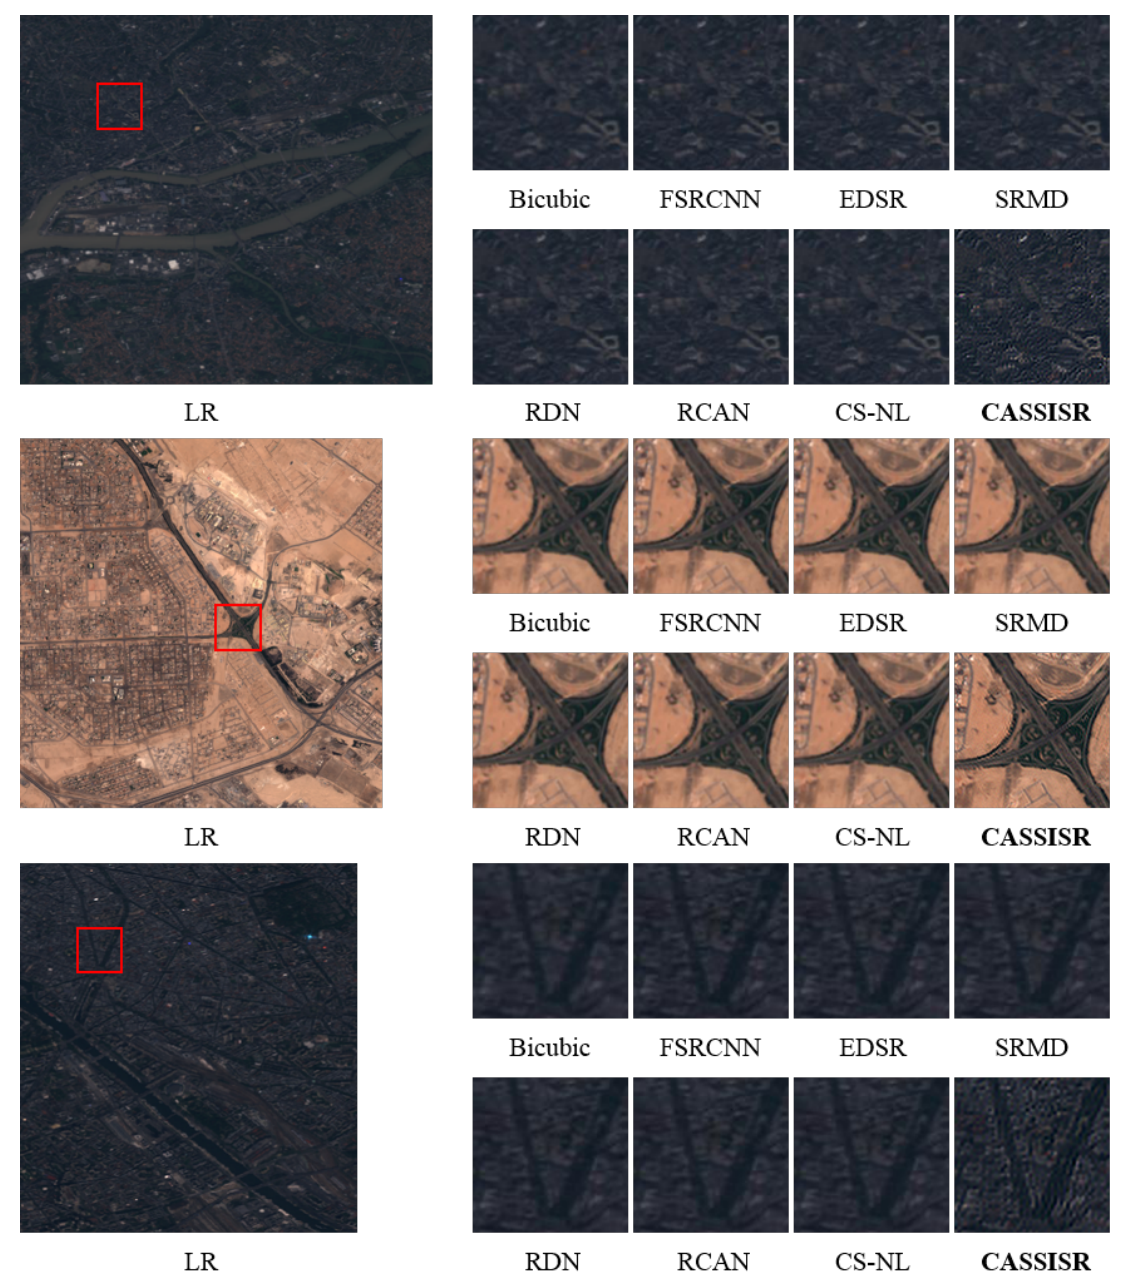
Figure 10. Qualitative comparison between CASSISR and CNN-based SR methods on real-world remote sensing